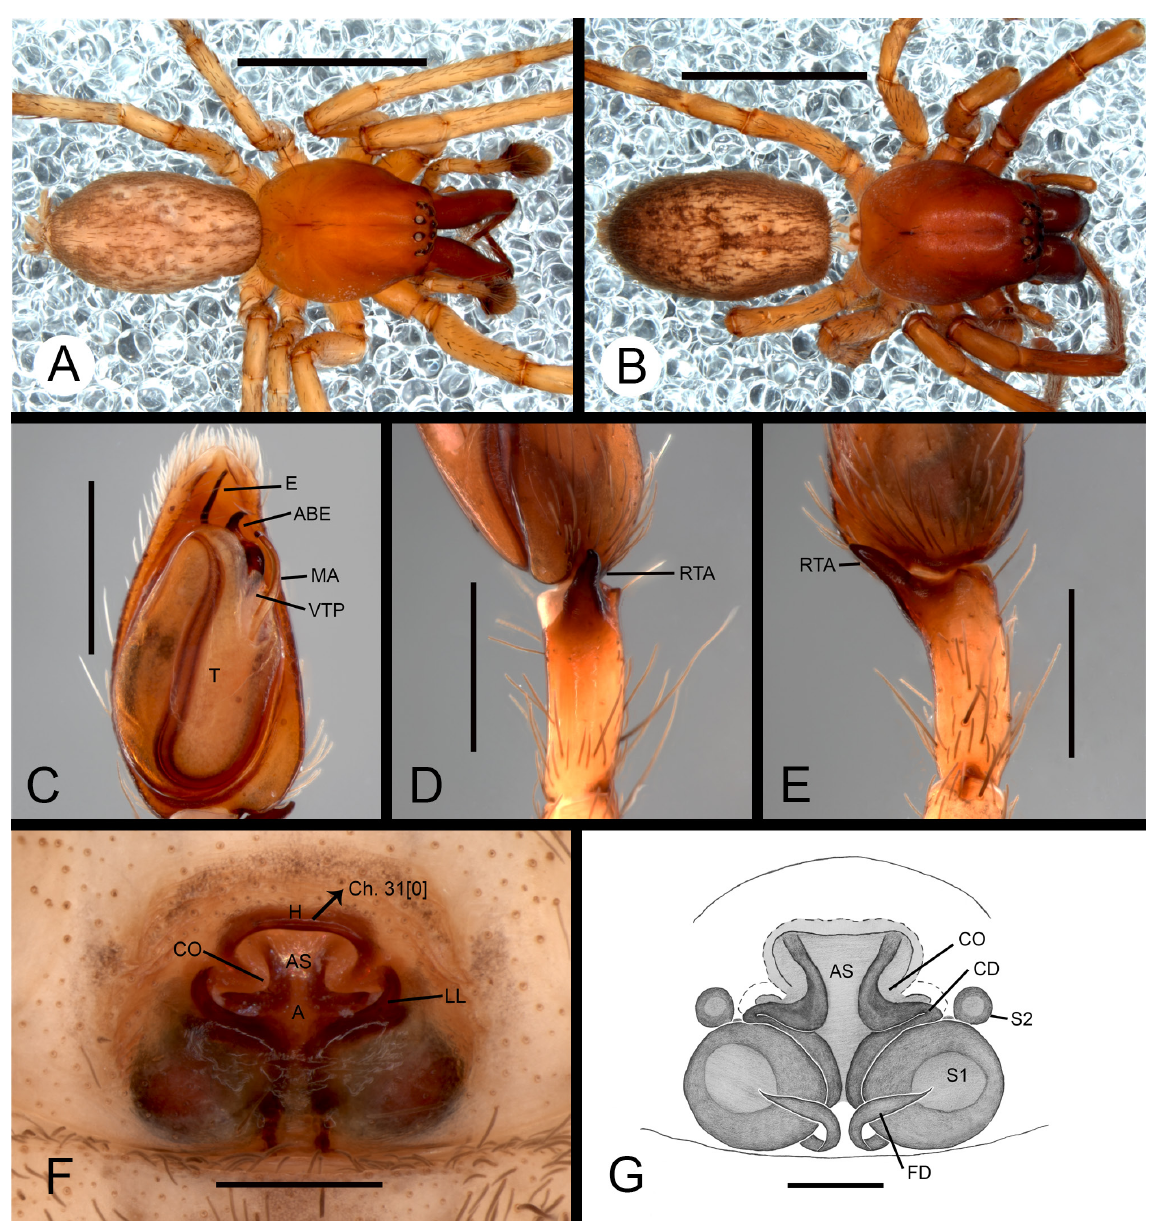
Fig. 14. Tafana kunturmarqa sp. nov. (A, C–E = holotype, ♂, ICN-Ar; B, F–G = paratype, ♀, ICN-Ar). A . Habitus, dorsal view. B . Habitus, dorsal view. C . Left palp, ventral view. D . Left palp, retrolateral view. E . Left palp, dorsal view. F . Epigynum, ventral view (arrow indicating character). G . Vulva, dorsal view. Abbreviations: A = atrium; ABE = apophysis of base of the embolus; AS = atrial septum; CD = copulatory ducts; Ch = character; CO = copulatory opening; E = embolus; FD = fertilization ducts; H = hood; LL = lateral lobes; MA = median apophysis; RTA = retrolateral tibial apophysis; S1 = primary spermathecae; S2 = secondary spermathecae; T = tegulum; VTP = ventral tegular process. Scale bars: A–B = 3.5 mm; C–E = 0.66 mm; F = 0.4 mm; G = 0.25